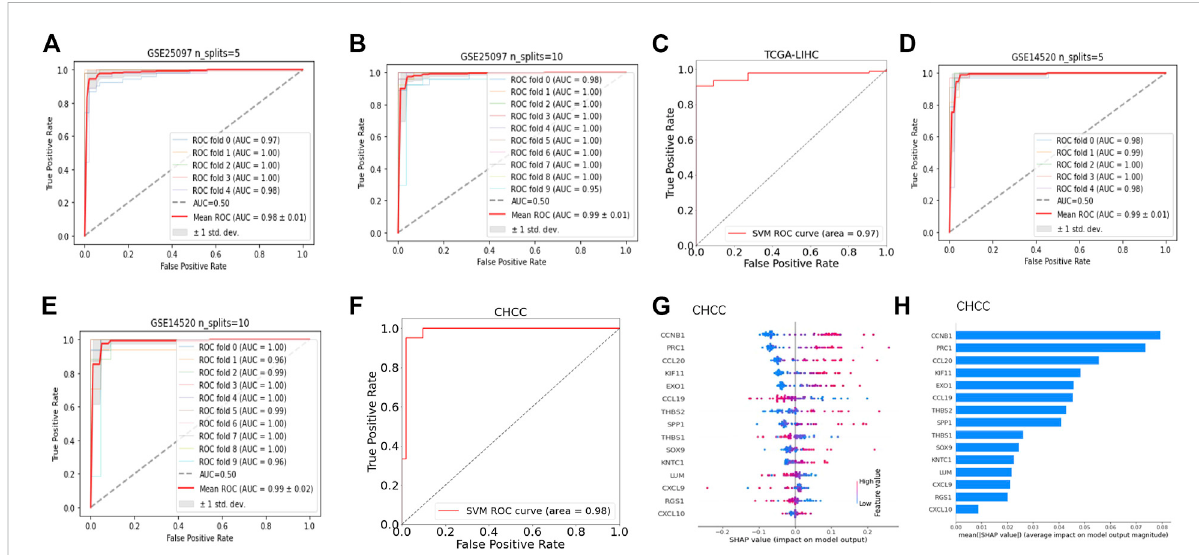
FIGURE 6 FifteenfeaturegenesofCLSTandaCD4werepromisingdiagnosticsignalsfortumortissueidenti fi cation. (A,B) ROCcurvesofexpressionvalues of 15 feature genes for HCC tumor prediction among HCC tumor, adjacent non-tumor, cirrhotic, and normal liver samples using SVM with strati fi ed K-fold cross-validations (n_splits = 5 and 10). (C) ROC curves of expression values of 15 feature genes as a diagnostic set for the separation of HCC tumors from non-tumor liver samples via SVM. (D,E) AUC of ROC curves of expression values of 15 feature genes as diagnostic markers for early-stage HBV-HCC tumor identi fi cation from non-tumor liver samples via SVM with strati fi ed K-fold cross-validations (n_splits = 5 and 10). (F) ROC curves of expression values of 15 feature genes as diagnostic markers for separation of tumor tissues at the early stage of HBV-HCC from non- tumor liver samples in the CHCC cohort via SVM. (G,H) SHAP pro fi les of 15 feature genes of the outperformed SVM model in the CHCC cohort. The dot plot shows the effect of the expression value of the feature gene on the model output. The bar plot shows the decreasing average feature importance of the expression value of the 15 feature genes on the in fl uence of the fi nal model output for predicting tumor tissues at an early